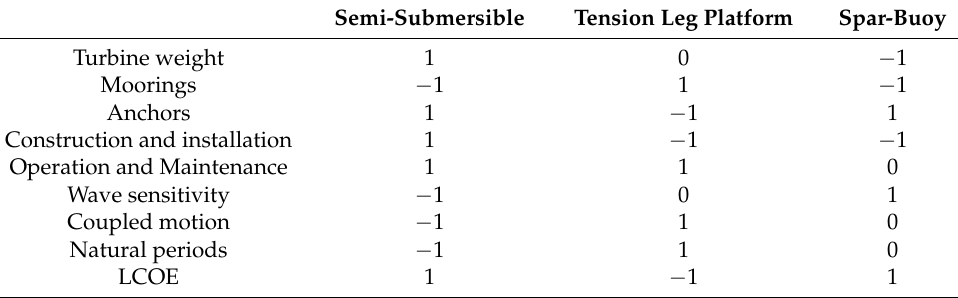
Table 2. Assessment of primary floating